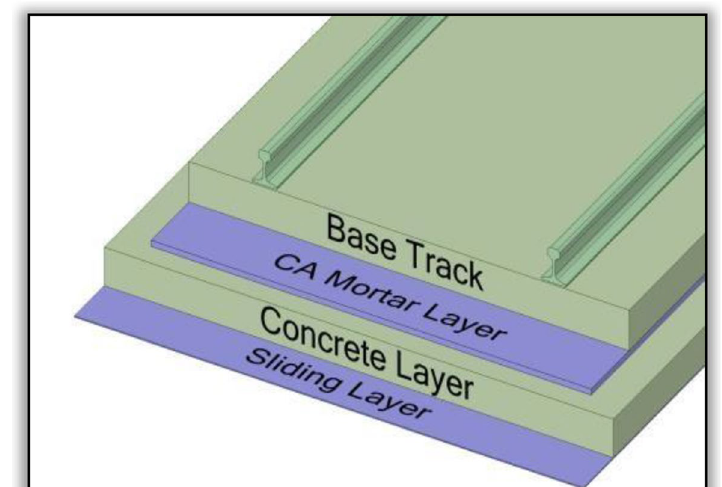
Fig. 5 Layers of sub-Track